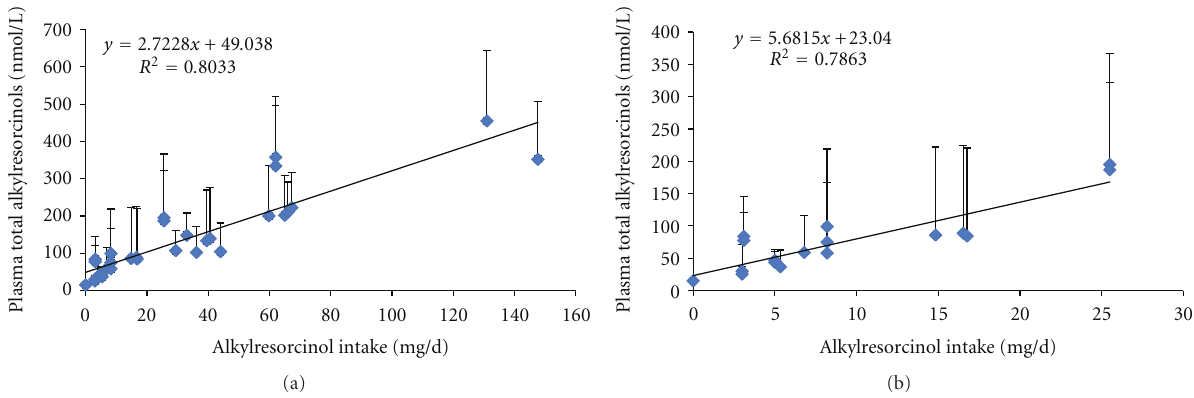
Figure 3: Relationship between mean AR intake and the mean of plasma AR across published studies (a). Where direct AR intake data was not provided, it was estimated from literature values if possible. Values are arithmetic means, and error bars are the standard deviation. Figure (b) uses data from studies where there has been an arm/group with an AR intake equivalent to 0–48 g of WG wheat (0–27 mg AR/d) to give an idea of the range at “normal” intakes, as well as the likely intercept for no WG intake.